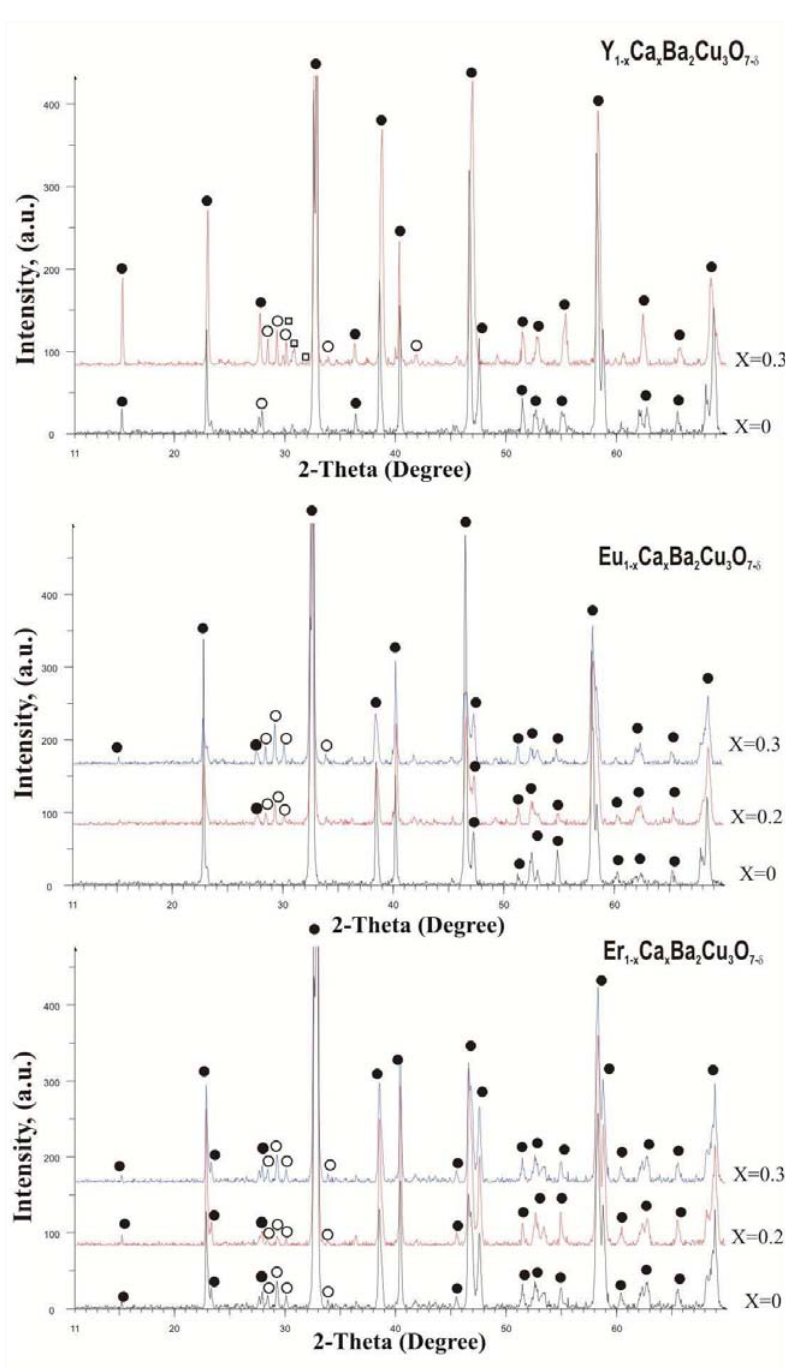
Fig. 1 XRD patterns using Cu-K α radiation for RE x=0, 0.2, 0.3) samples; a - RE=Y, 1-x=0, 2-x=0,3; b- RE=Eu, 1-x=0, 2-x=0.2, 3-x=0.3; c - RE=Er, 1-x=0, 2-x=0.2, 3-x=0.3; The symbol ( • ) indicates main peaks of 123 phase; ( (cid:2) ) – 211, ( ◦ ) – BaCuO 2